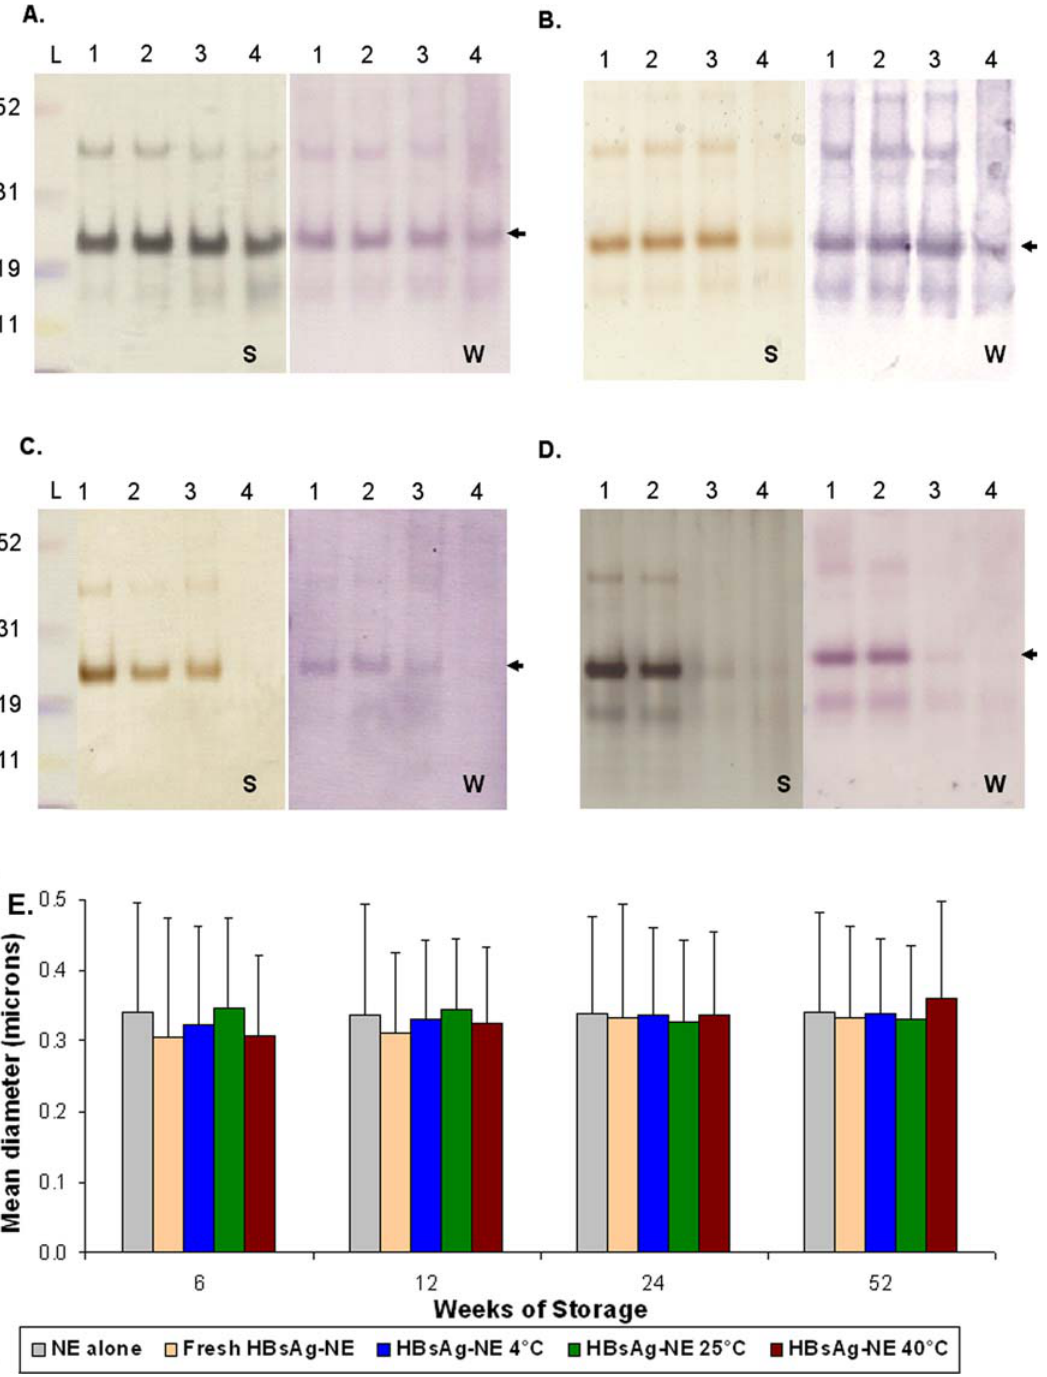
Figure 7. In vitro analyses of HBsAg-NE stability. The comparison of HBsAg-NE stored at test temperature conditions to freshly prepared formulation using SDS-PAGE followed by silver staining (S) or Western immunoblotting (W) is shown. Lanes are labeled according to sample storage conditions as follows- 1: fresh, 2: 4 u C, 3: 25 u C and 4: 40 u C. Samples were stored for (A) 6 weeks, (B) 6 months (24 weeks), or (C) 1 year (52 weeks) at the three test temperatures. Each lane contains 0.5 m g of antigen. Arrow indicates the HBsAg major band. (D) Particle size comparison of NE alone to freshly mixed HBsAg-NE and formulation stored up to a year. Mean diameter of particles is shown in microns + / 2 SD.